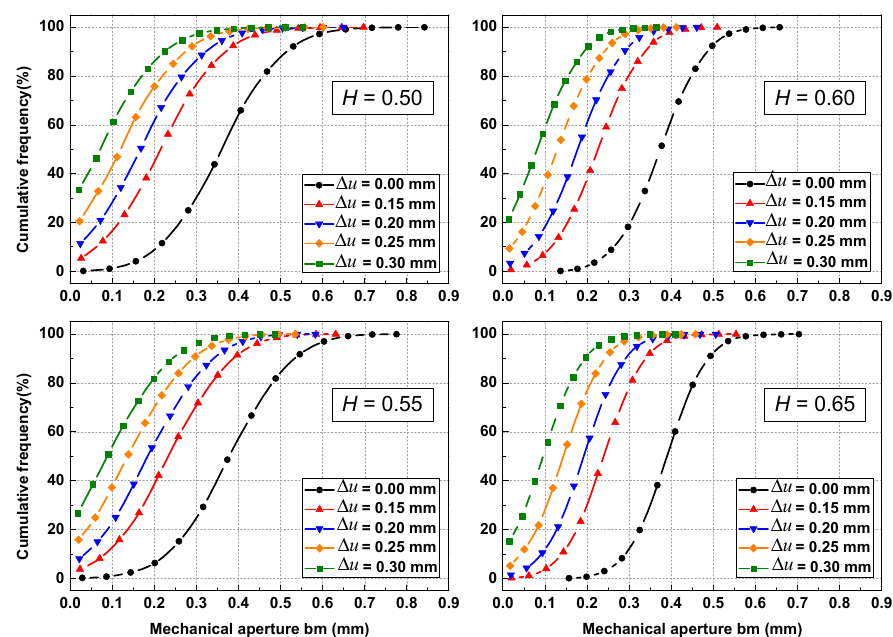
Figure 4. Cumulative probability distribution of fracture aperture for fractures with different normal deformations ( ∆ u ) and H .